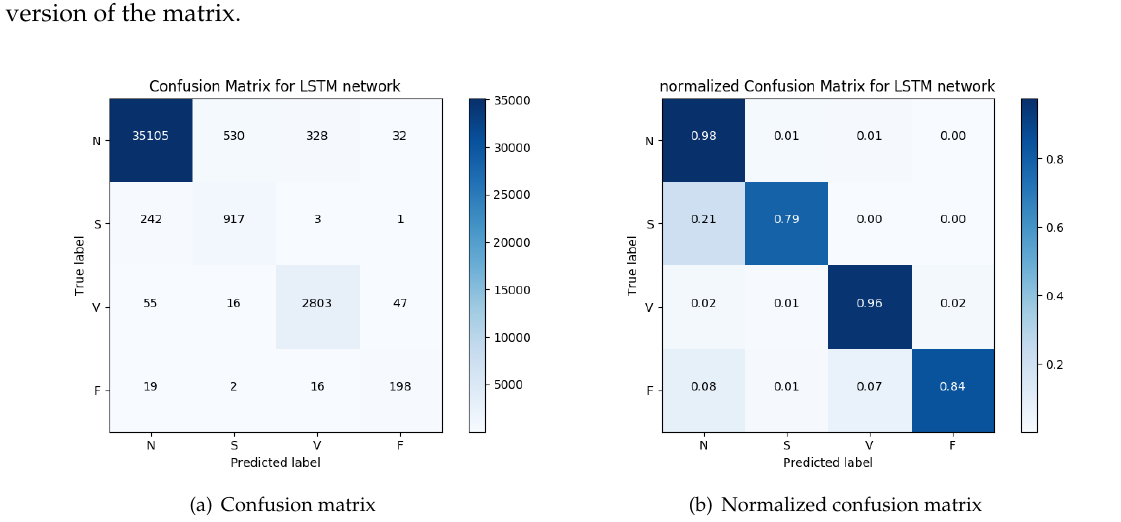
Figure 9. The actual beats included in the MIT-BIH database for each category and the classification of the beats produced by the arrhythmia-classification module.